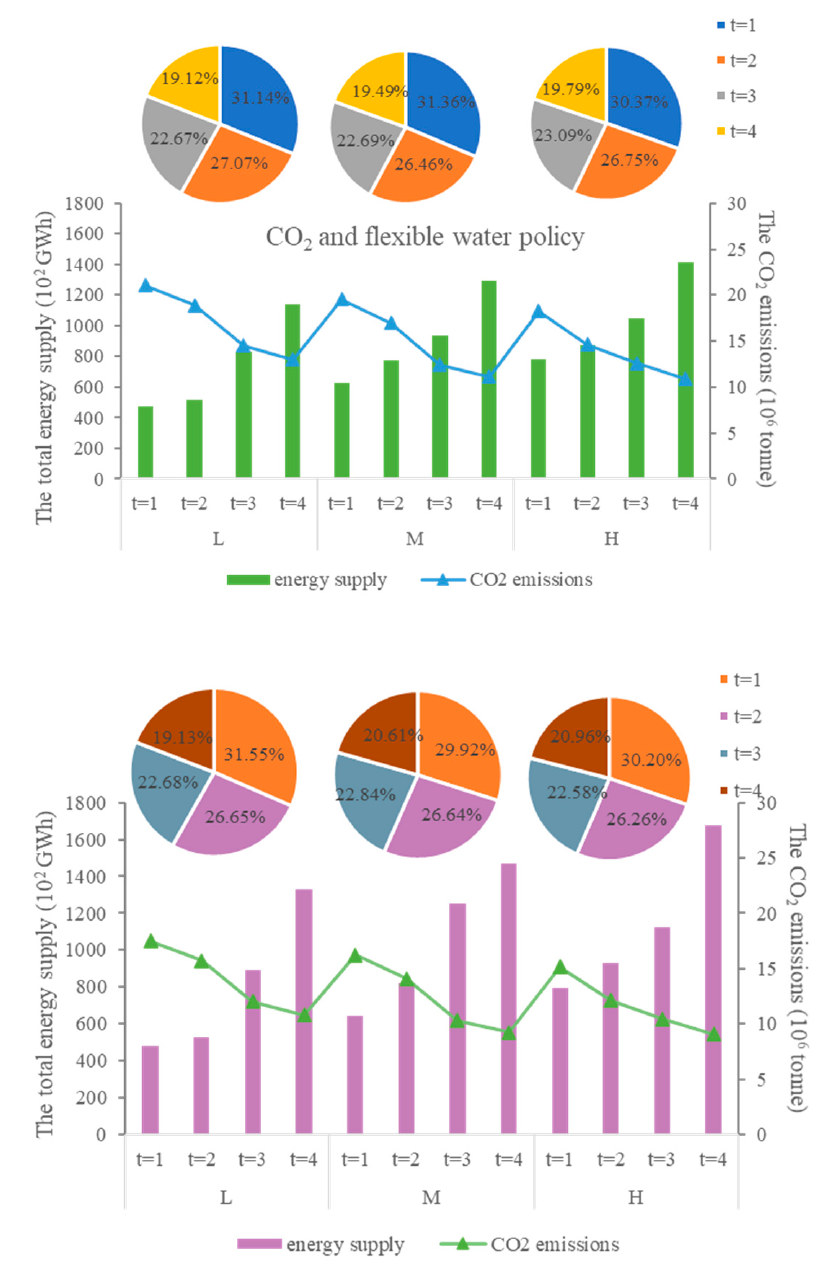
Figure 6. Cont Figure 6. The energy–water–CO 2 synergetic relationship under different scenarios.